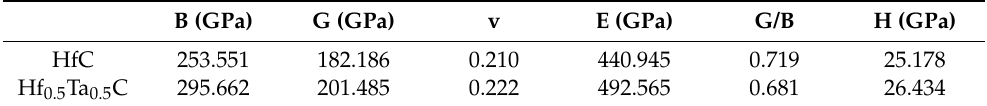
Table 4. The calculated elastic